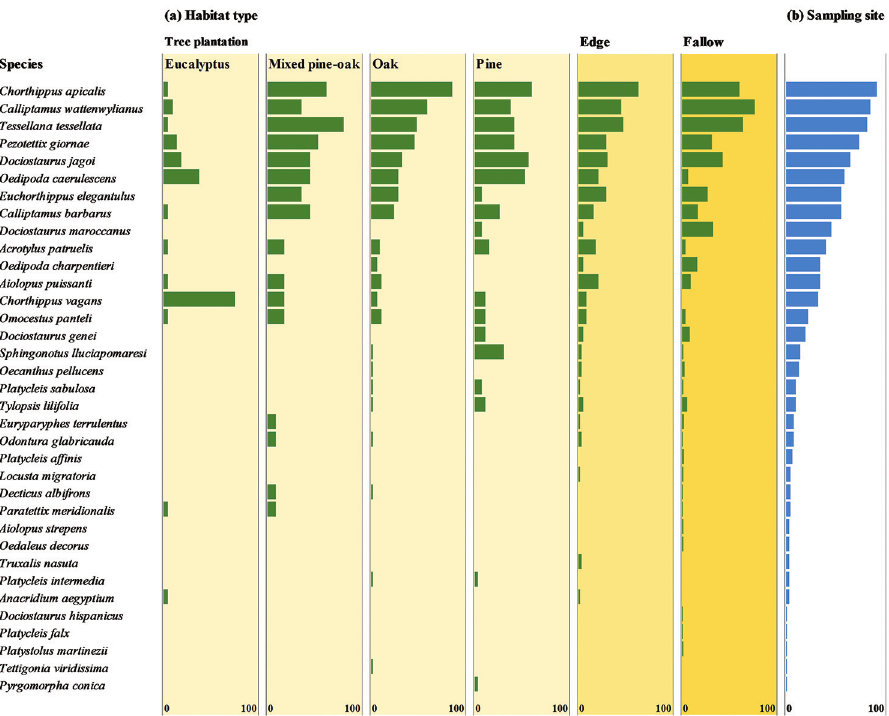
Figure 3. Frequency of occurrence (%) of each Orthoptera species per habitat type, calculated by divid- ing the number of occurrences by the number of transects in each habitat type ( a ), and percentage of sampling sites where the species occurred ( b